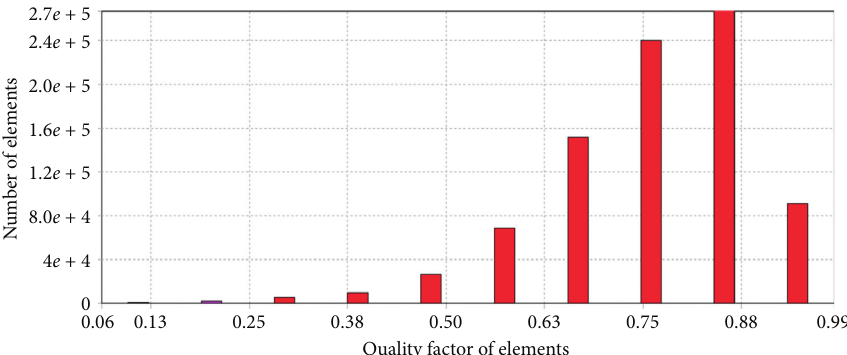
Figure 5: Orthogonal quality of meshes bar